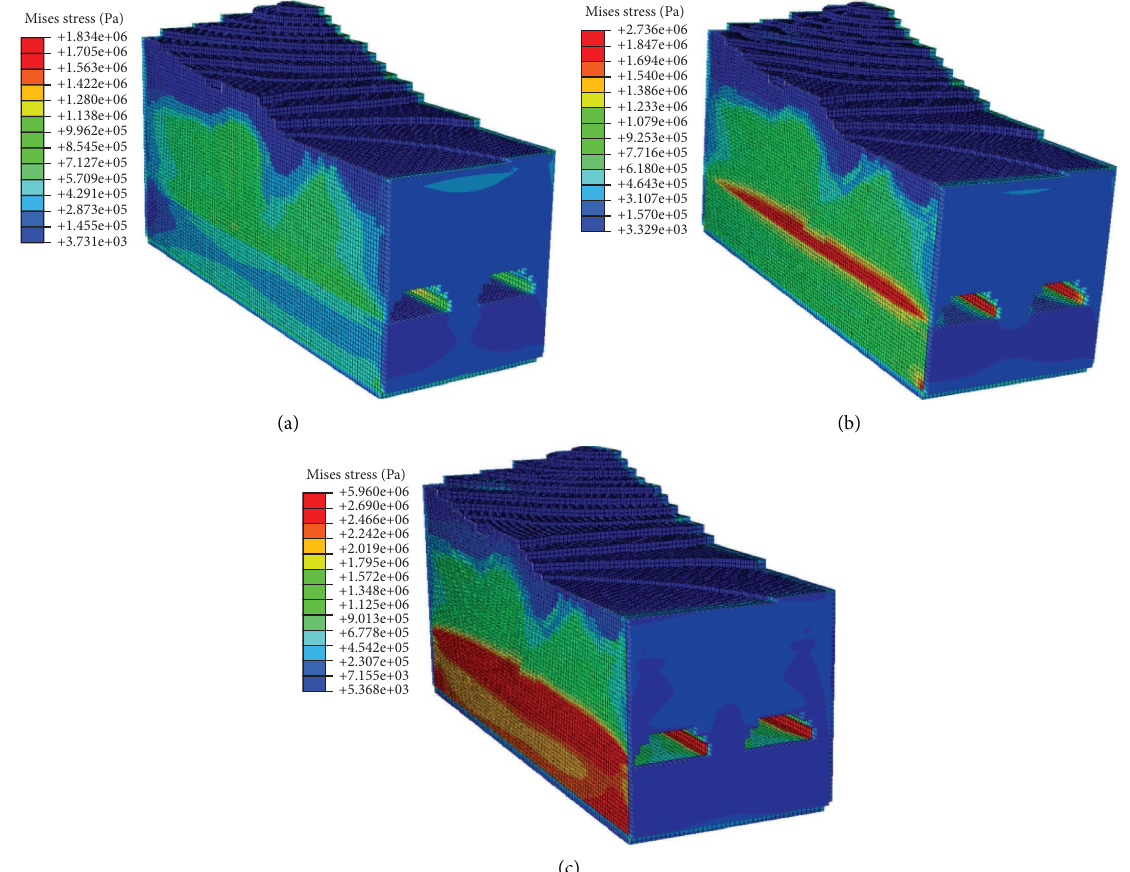
Figure 14: Mises stress under diferent seismic intensities ( t � 5s). (a) VI. (b) VII. (c) VIII.